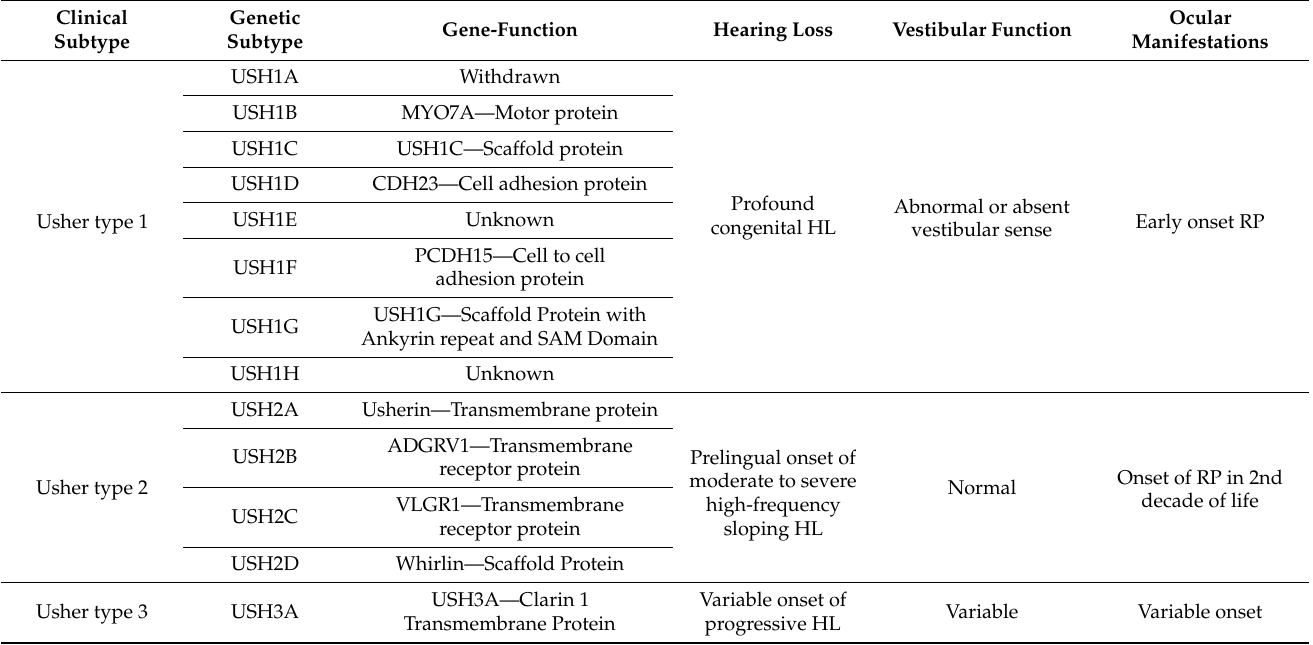
Table 1. A summary of Usher syndrome